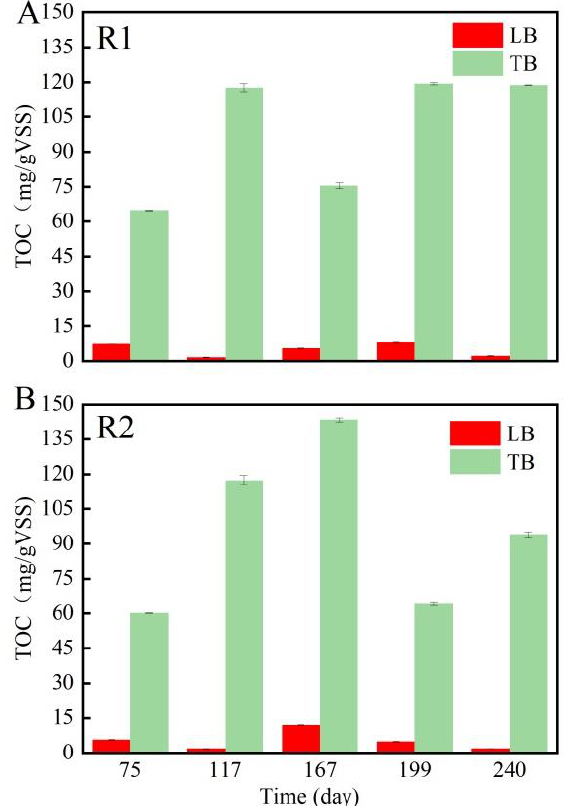
Figure 6. LB-EPS and TB − EPS contents in aerobic granules in R1 and R2 during the long-term operation period. ( A ) for R1; ( B ) for